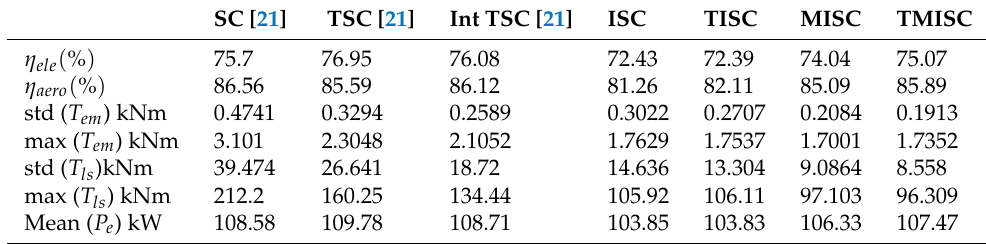
Table 1. Comparative analysis of controllers.